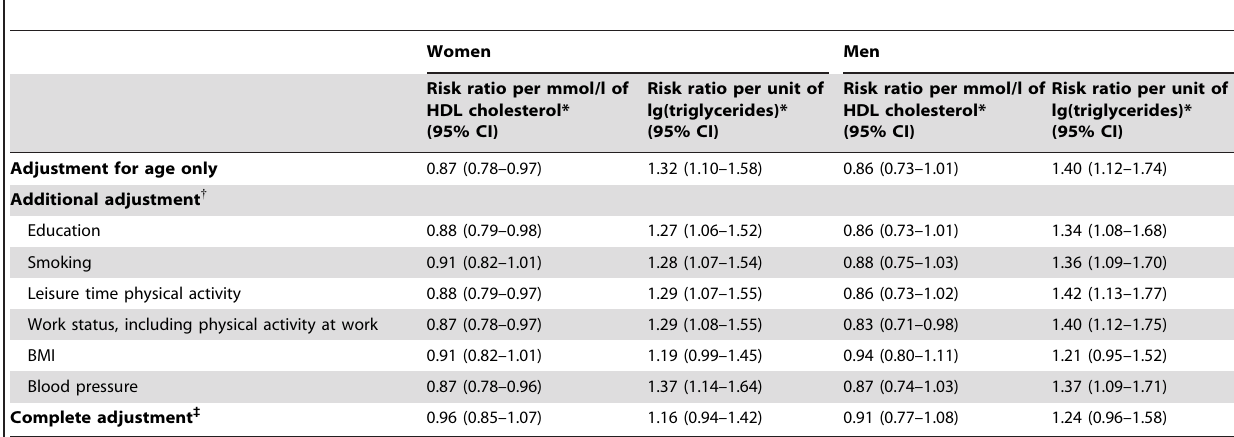
Table 3. Log-linear associations between HDL and triglyceride levels and risk of chronic LBP among individuals without chronic LBP at baseline, with adjustment for different variables.